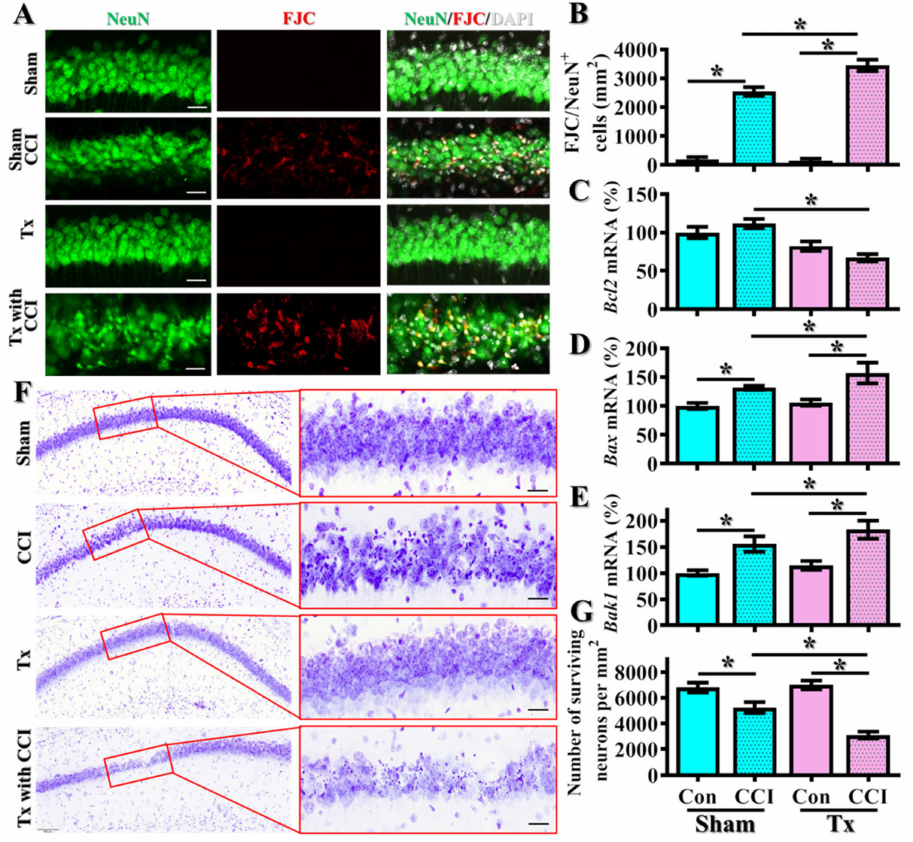
Figure 5. Increase in TBI-induced neuronal loss after surgical thyroidectomy. ( A , B ) Quantification and representative images of FJC-positive degenerating neurons in the hippocampus. n = 15 images from 5 mice; ( C – E ) Quantification of the relative expression levels of Bcl2 , Bax and Bak1 mRNAs from different experimental groups. n = 5 mice. ( F , G ) Quantification and representative images of Nissl stains showing the surviving neurons in the hippocampus. n = 15 images from 5 mice. Data are presented as mean ± SEM ( B – G ) and analyzed by a one-way ANOVA with Bonferroni’s post hoc analysis. * p < 0.05. Scale = 25 µ